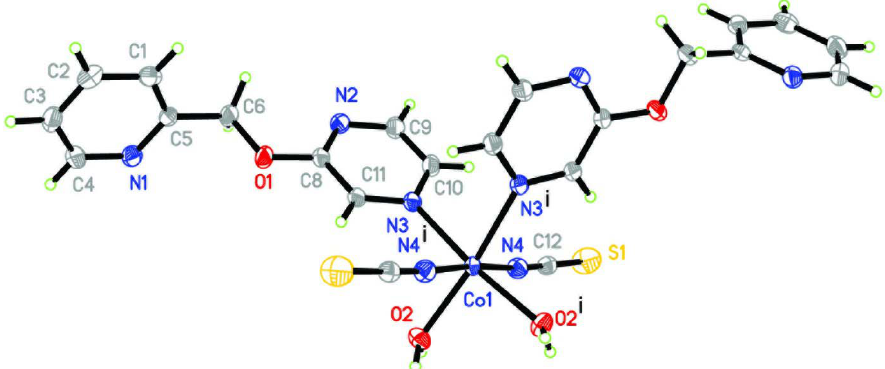
View of complex (I), showing the the asymmetric atom numbering scheme with thermal ellipsoids drawn at the 30% probability level. (symmetry code: (i) - x , y , - z +